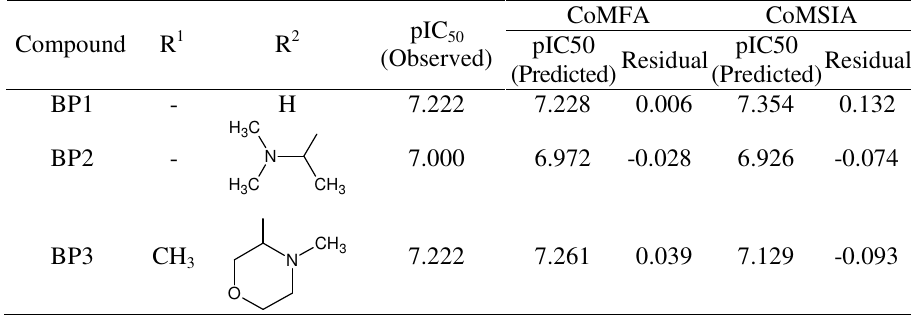
Table 1(a). Structures and biological activities of molecules used in the present study